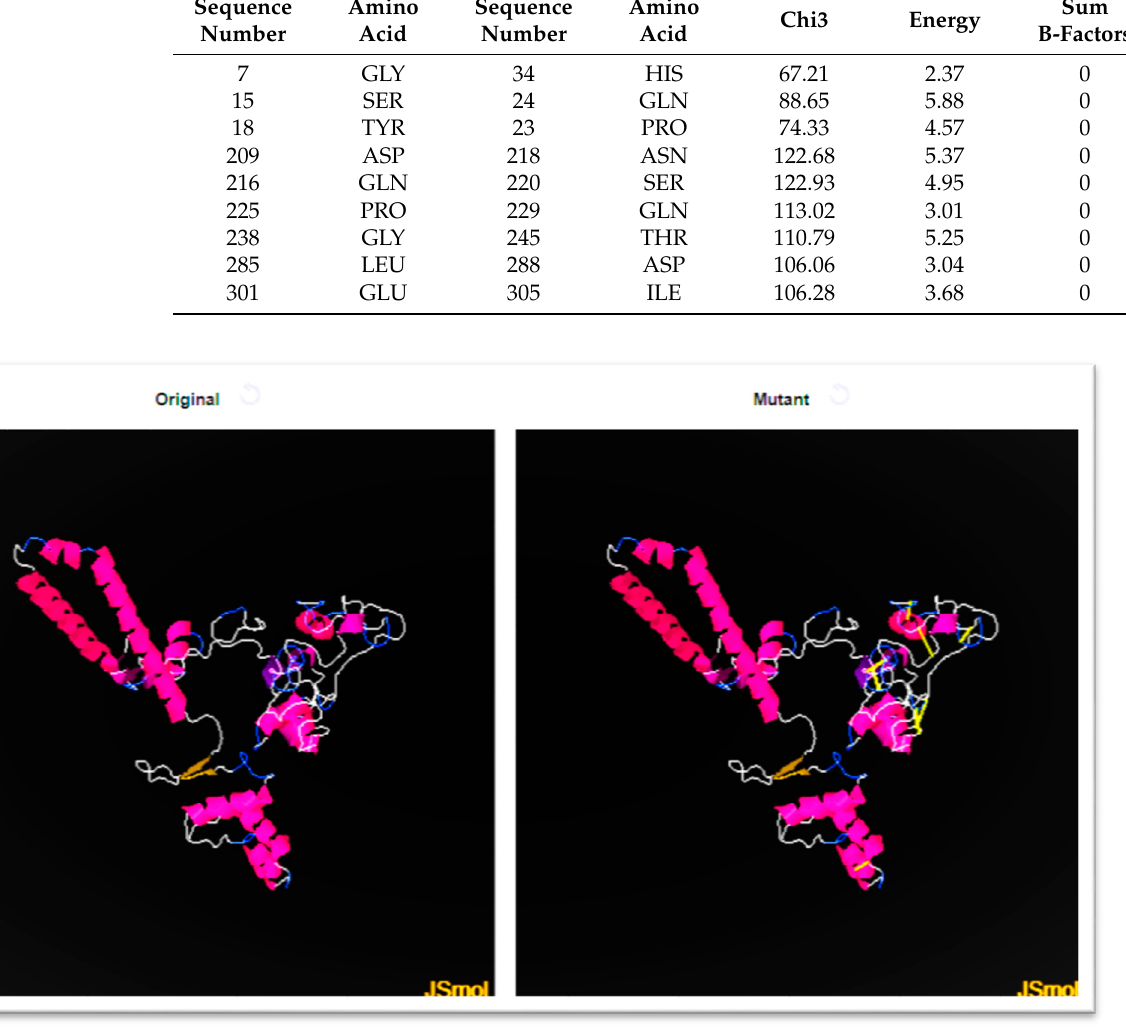
Figure 8. A mutated and wild vaccine construct. Mutated structures show yellow bands where disulfide bonds have been introduced.